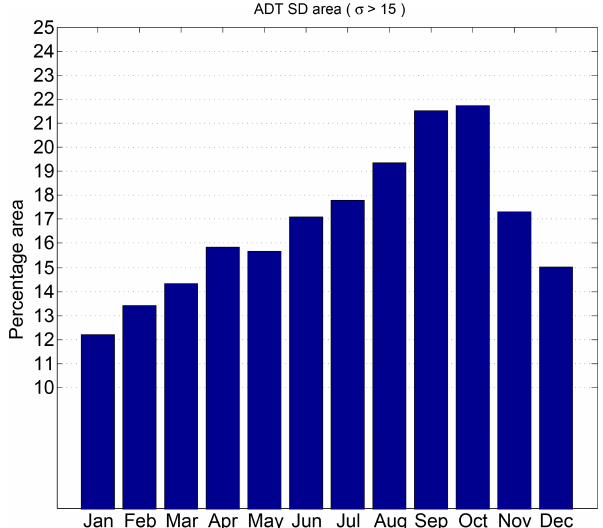
Figure 5. Average monthly percentage surface areas of CW in the interior of the Gulf of Mexico determined from climatology of the SD contour >15cm; enclosed areas were calculated in relation to the GoM area (1 . 56 × 10 6 km 2